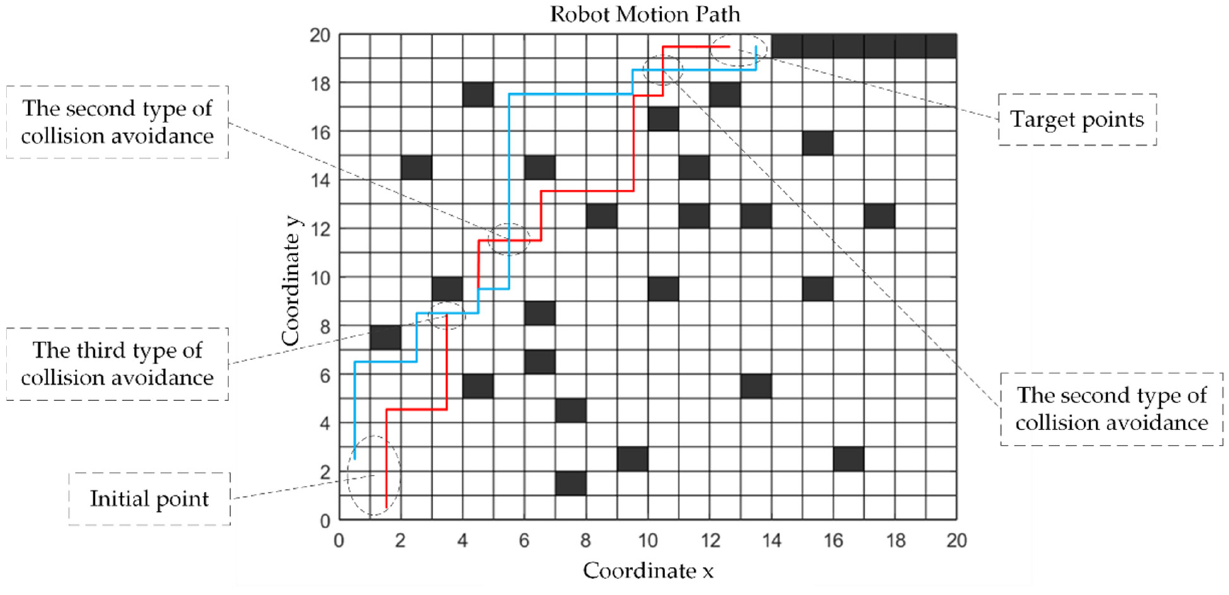
Figure 15. Module collaborative path planning diagram.